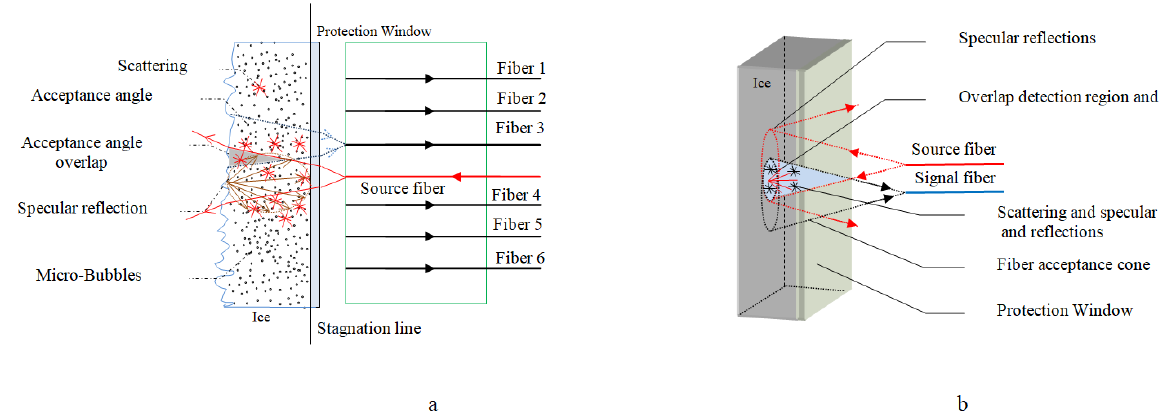
Figure 3. ( a ) Schematic diagram of reflected and backscattered light from the ice–air interface which falls within the acceptance angle of the signal fibers. ( b ) Backscattered light which is detected by the signal fibers.